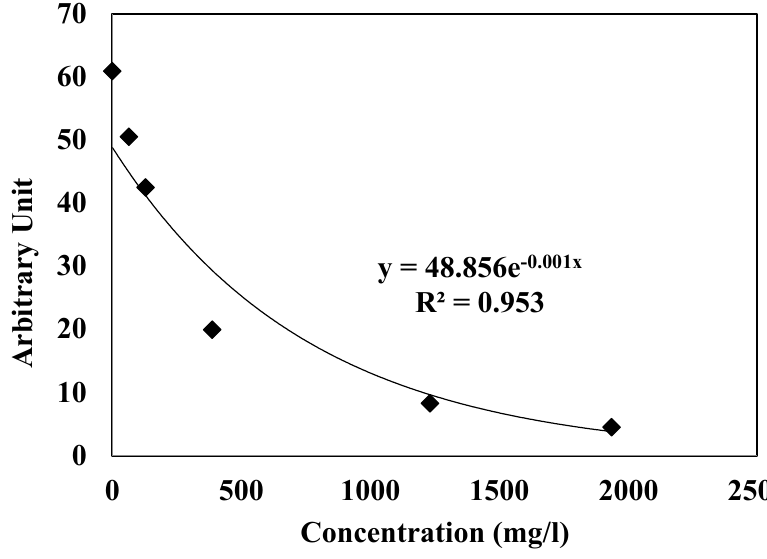
Figure 1. Antioxidant activity determined by the Electron paramagnetic resonance (EPR) spectrum of the radical adduct DMPO-OCH 3 generated from a solution of H 2 O 2 (2 mM) and FeSO 4 (0.04 mM) with DMPO (14 mM) as spin trap in MeOH as solvent. The EPR signal decreases with the higher antioxidant